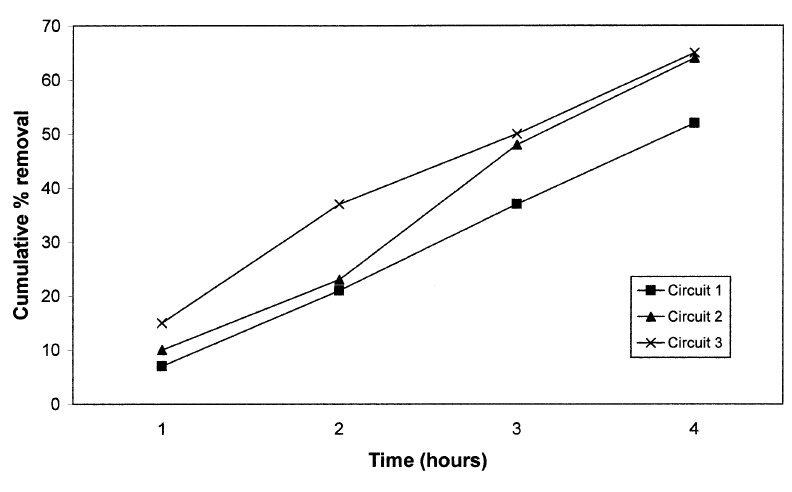
Fig. 6. Graph showing removal rate with time on 3 circuits used once only.